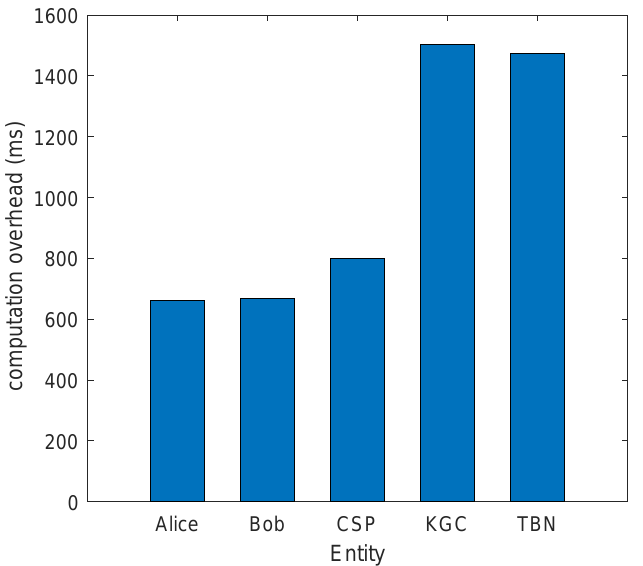
Figure 8. Computation overhead of each entity.